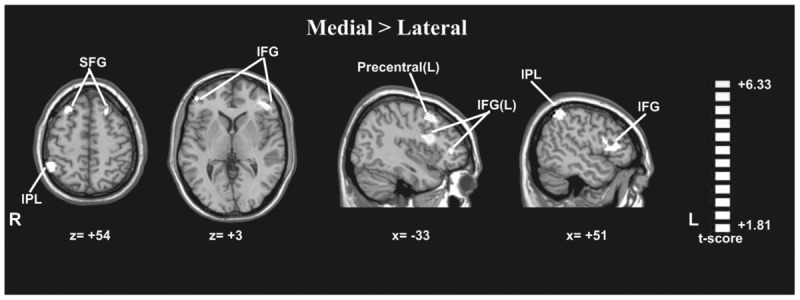
Statistically different t-maps between the medial and lateral drawings (paired t-test, p < 0.05, corrected). t-score bars are shown on the right. The numbers beneath the images refer to the MNI coordinates.